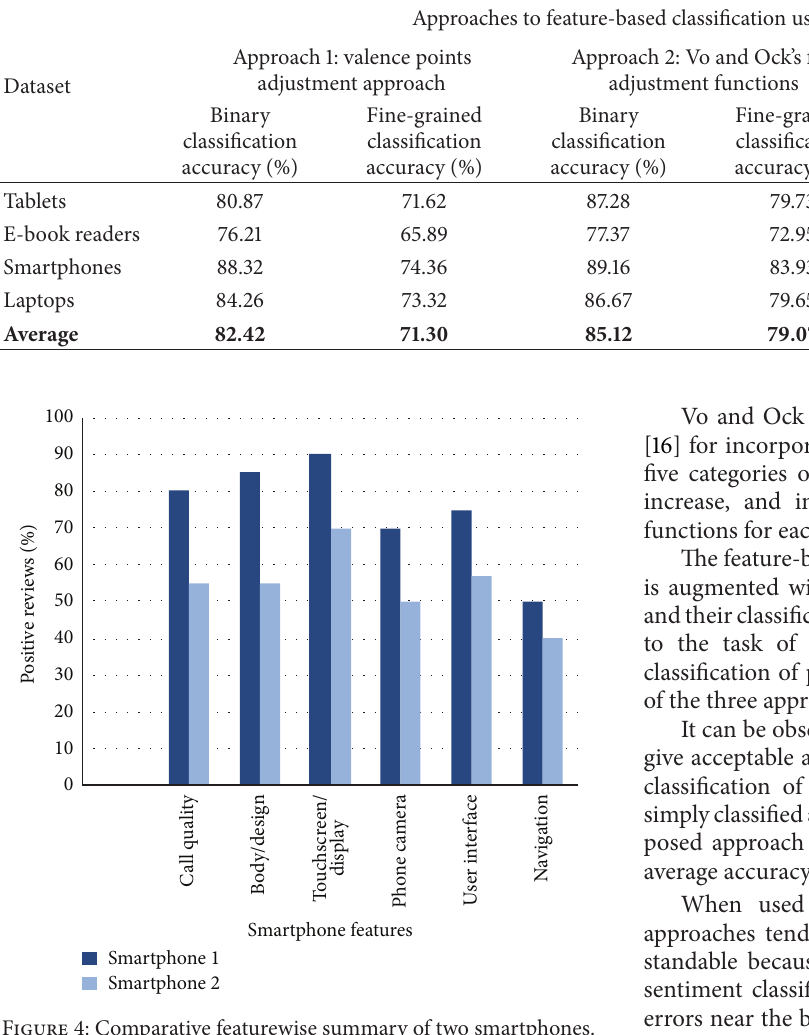
Table 3: Accuracy of feature-based opinion classification using linguistic hedges.